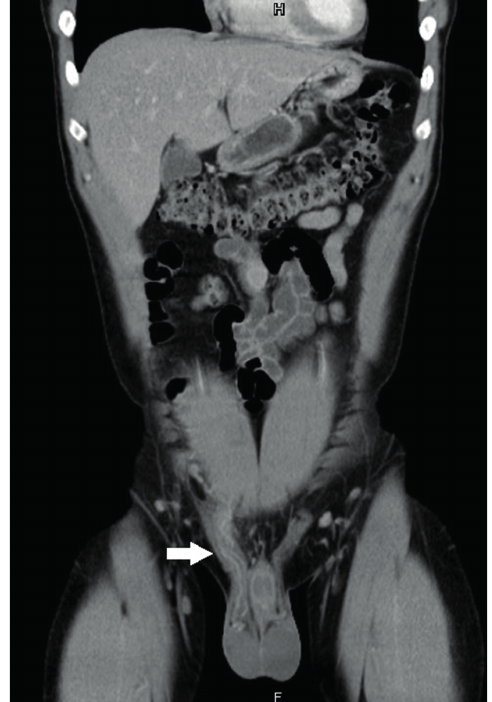
Figure 2 - Prominent thickening of the right spermatic cord as compared to normal left spermatic cord on coronal